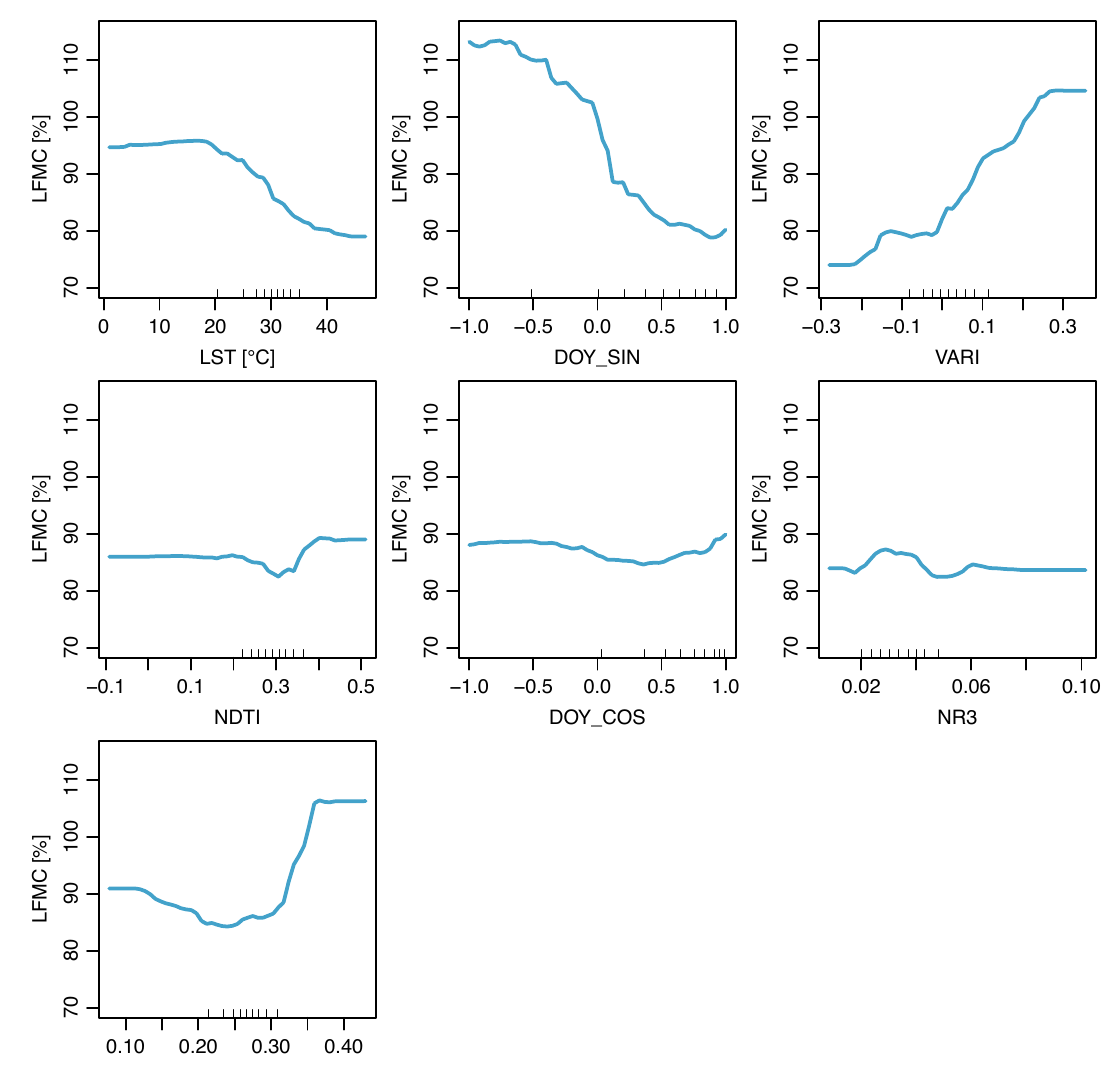
Figure 6. Partial dependence plots from the fitted model. Blue lines describe the average effect of a given predictor in the LFMC estimates. Small lines in the x axis indicate the deciles of the predictor